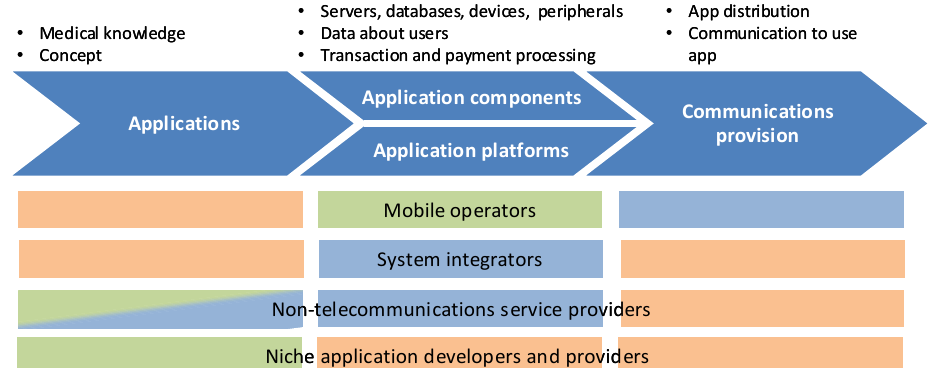
No clear advantage or